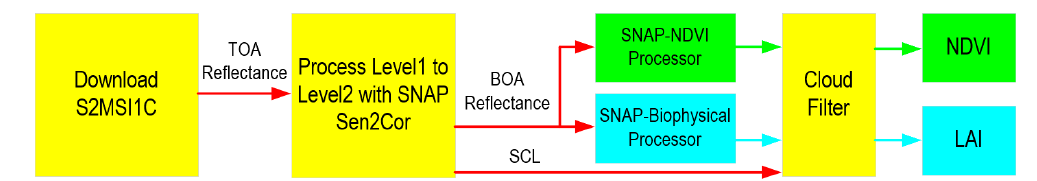
Figure 8. Data processing for Sentinel–2’s NDVI/LAI product generation.